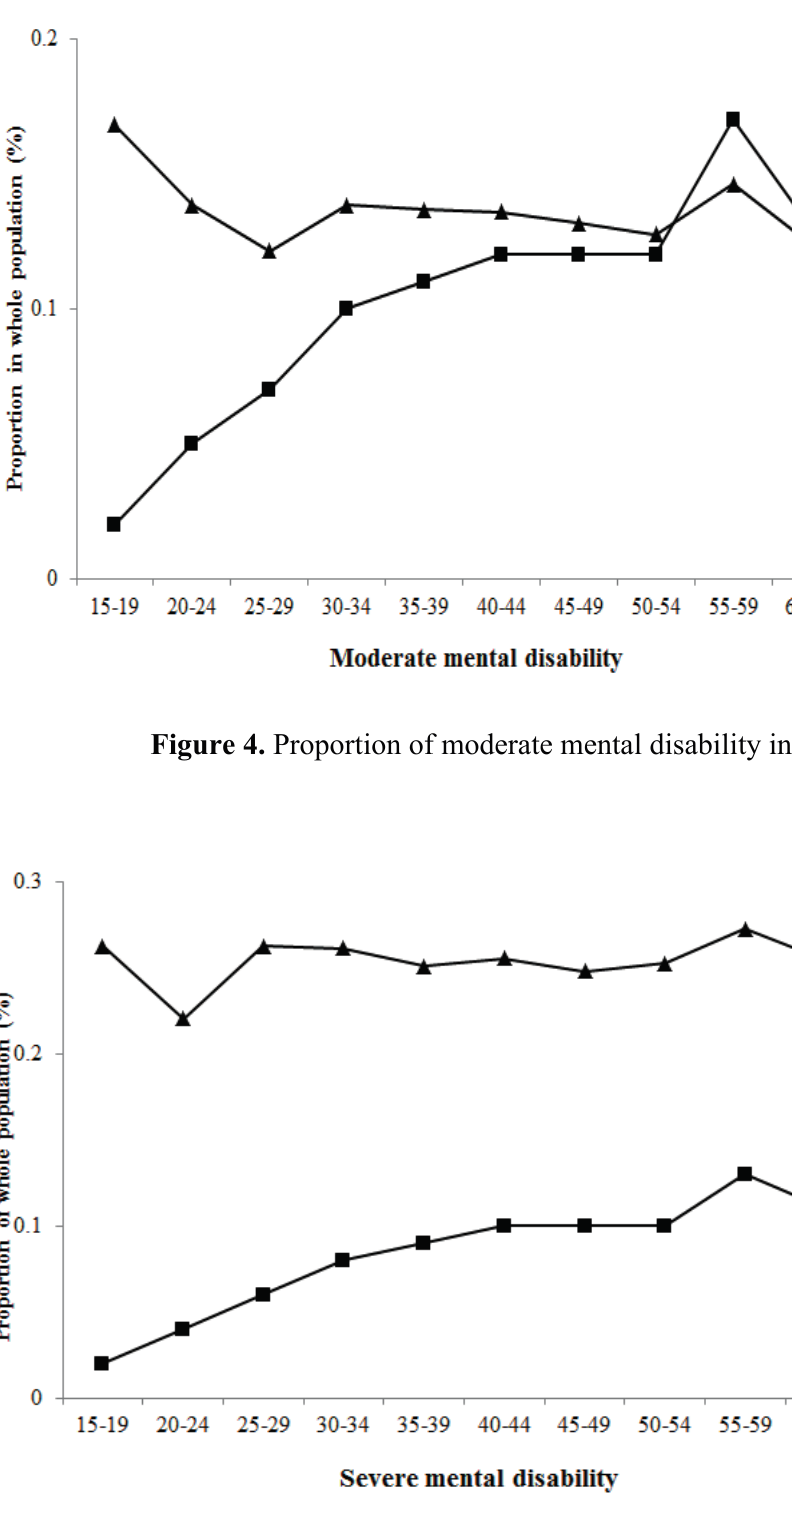
Figure 5. Proportion of severe mental disability in different age